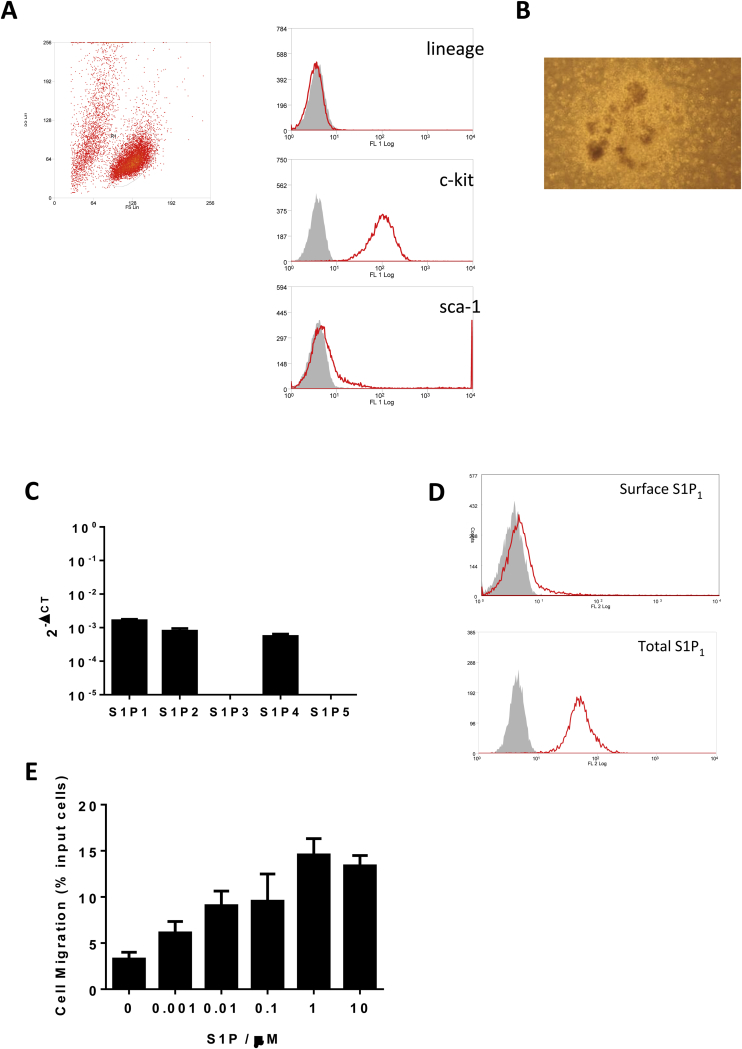
Characterization of HPC-7 cell line. (A) Cultured HPC-7 cells were labeled with fluorescently conjugated antibodies to lineage markers (CD11b, CD5, CD8a, Ter119, Gr-1, and B220), c-kit, and sca-1, and analyzed by flow cytometry. Dead cells and debris were excluded by gating on a plot of forward scatter–side scatter and surface expression of lineage markers, c-kit, and sca-1 were measured. Representative histograms are shown (isotype control, grey area; antibody, red line). (B) HPC-7 cells were cultured in MethoCult GF media for 7 days and significant numbers of myeloid colony-forming cell clusters were identified. Representative image of colony forming unit granulocyte macrophage colony shown. (C) Gene expression of S1P receptors 1–5 in cultured HPC-7 cells relative to glyceraldehyde-3-phosphate dehydrogenase by the 2-ΔCT method was determined. Bars represent means ± SEM expression in 3 independent experiments. (D) Surface S1P1-receptor expression on cultured HPC-7 cells was analyzed by flow cytometry. After fixation and permeabilization of the cells, total intracellular S1P1-receptor expression also was assessed. Representative histograms of 3 independent experiments are shown (grey area, isotype control; red line, S1P1 antibody). (E) A total of 1 × 106 HPC-7 cells were added to the top well of the Transwell and migration to varying concentrations of S1P proceeded for 4 hours. Cells migrating into the bottom well were counted using flow cytometry and expressed as a percentage of the total number of HPC-7 cells added to the top well. Bars represent the means ± SEM of 3 separate experiments.